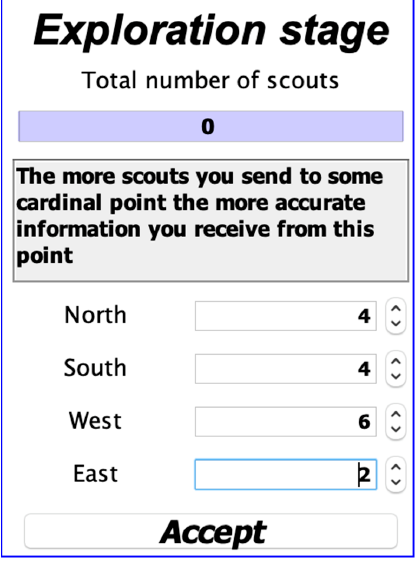
Figure A4. Scouts distribution window.